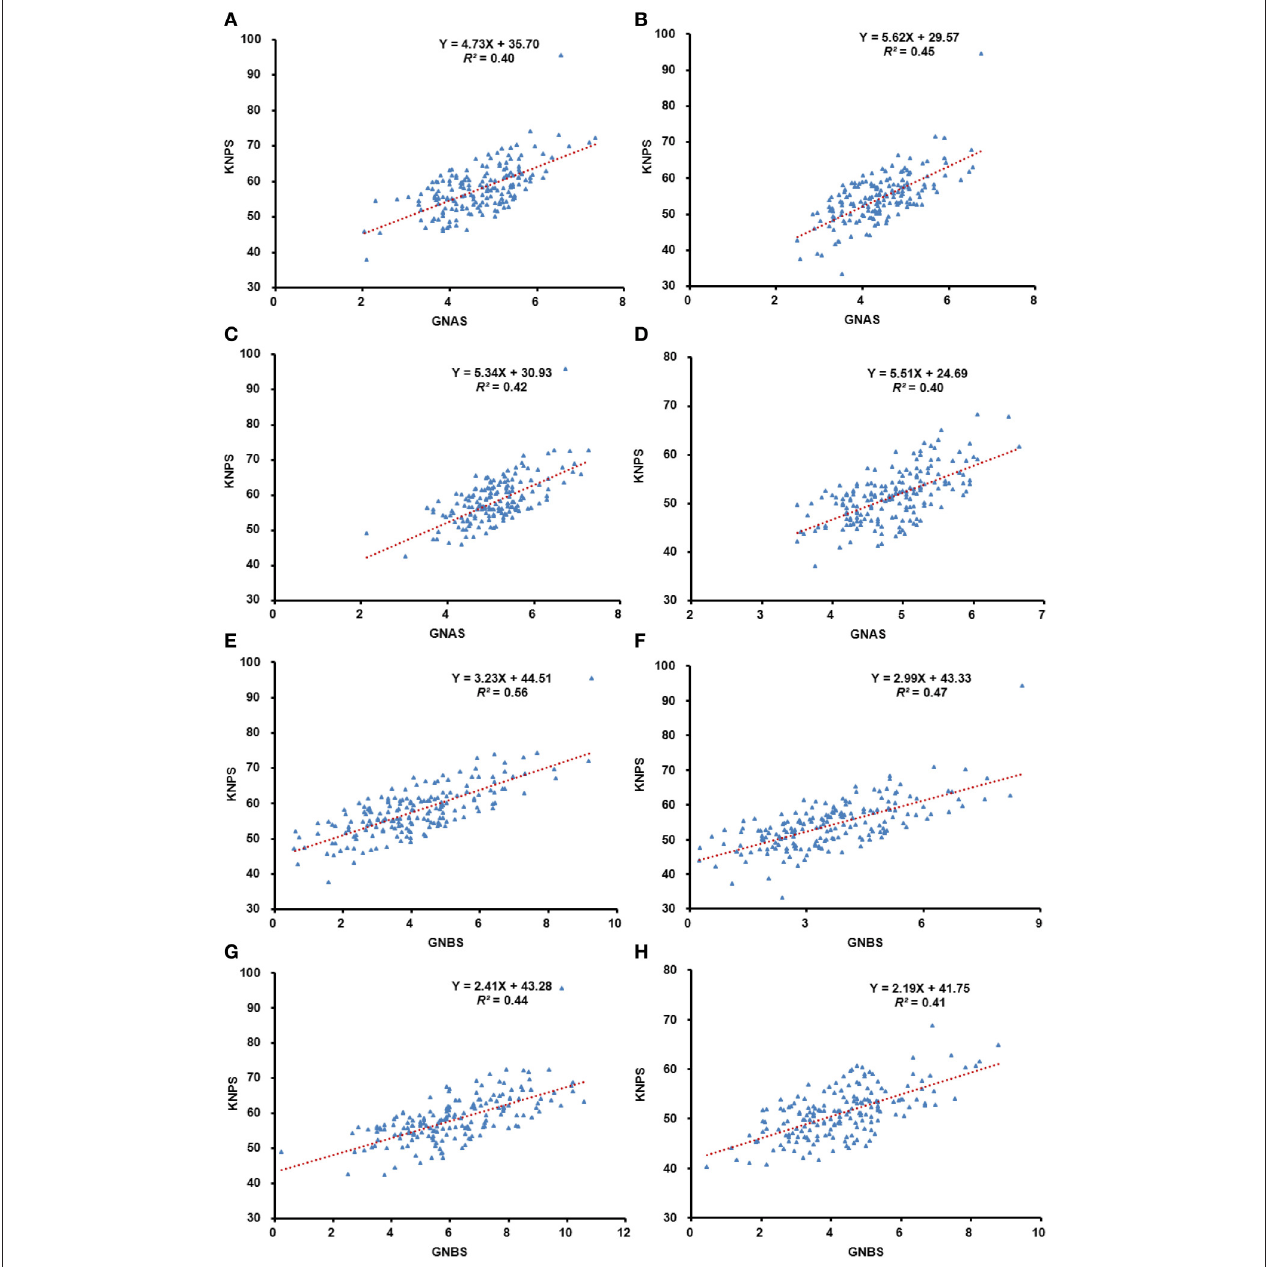
FIGURE 1 | Analysis of regression between grain-setting in the whole spike, and apical and basal spikelets, respectively. Blue dots represent the phenotypic value and the red dotted lines represent the predicted regression line. The correlation between grain-setting in apical spikelets and kernel number per spike in 13JZ (A) , 13YZ (B) , 14JZ (C) , and 14YZ (D) ; Correlations between the grain-setting in basal spikelets and kernel number per spike in 13JZ (E) , 13YZ (F) , 14JZ (G) , and 14YZ (H) .